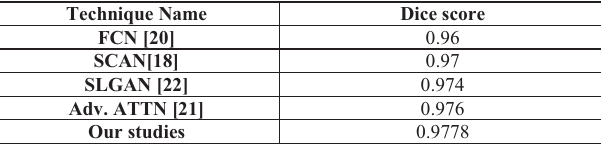
TABLE 1 . DICE SCORE COMPARISON BETWEEN OF DIFFERENT ARCHITECTURES IN OUR DATASET.